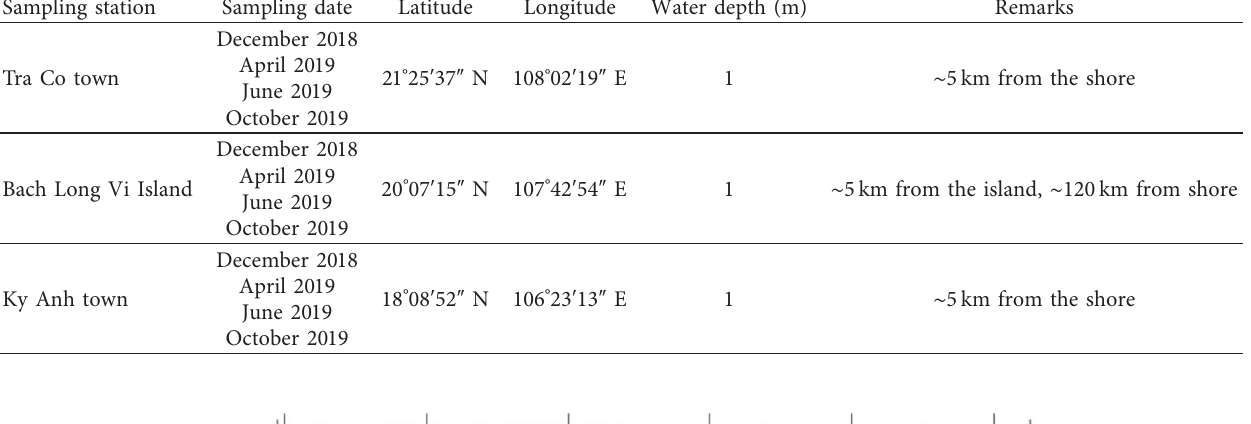
Table 1: Sampling locations in the Gulf of Tonkin.